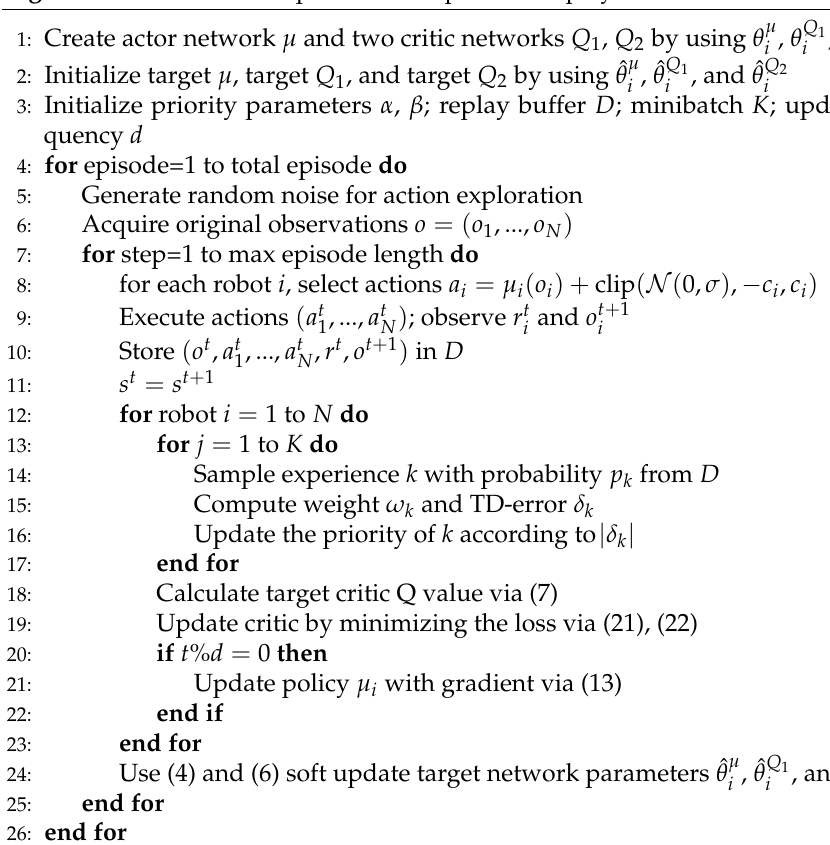
Algorithm 1 MATD3 with prioritized experience